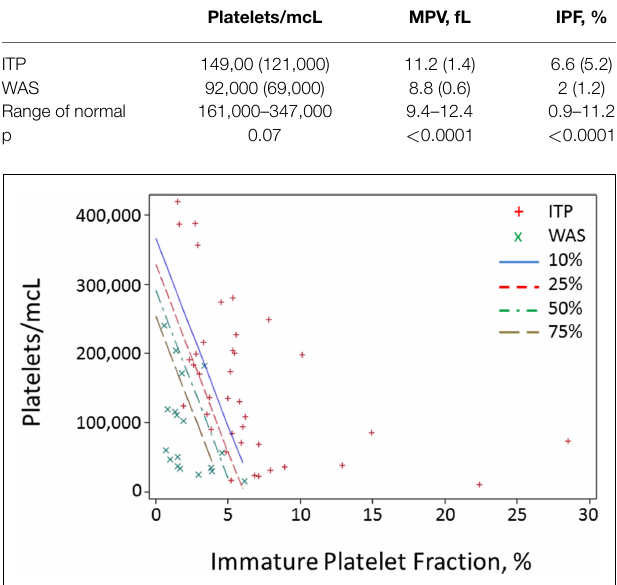
FIGURE 1 | Probability contours for a predictor based on IPF and platelet value . For each subject in the derivation cohort, all blood draws with data on both platelet count and IPF were selected, and all values for the two parameters were averaged for each subject and plotted. Red crosses represent averages for ITP subjects and green x ’s represent subjects with WAS. Contour lines represent different probabilities of a subject having